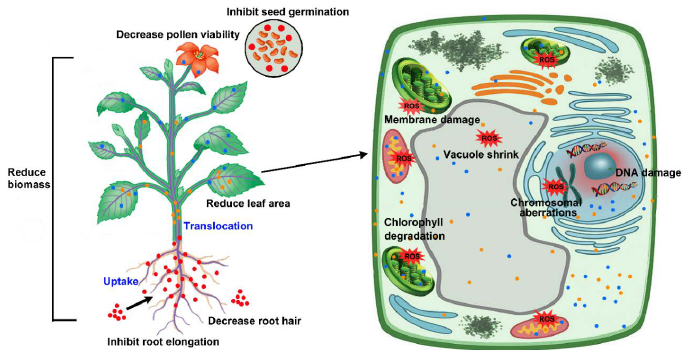
Figure 1. Schematic diagram representing uptake, translocation, and major phytotoxicity of silver nanoparticles (AgNPs) in plant (modified from Reference [102]). Generally, AgNPs are taken up by underground tissues (primary roots and lateral roots), then translocated to aboveground parts (stem, leaf, flower, etc.), where they can reduce biomass, decrease leaf area, affect pollen viability, and inhibit seed germination. At the cellular level, AgNPs enter into various organelles, leading to the production of excess reactive oxygen species (ROS), thereby causing cytotoxicity and genotoxicity, such as membrane damage, chlorophyll degradation, vacuole shrinkage, DNA damage, and chromosomal aberrations.